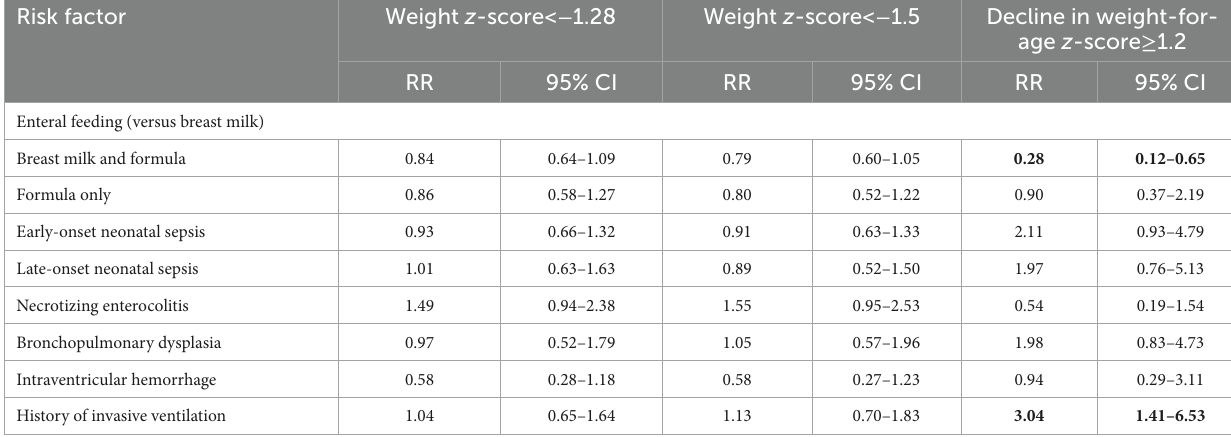
TABLE 4 Multivariate analysis on risk factors associated with postnatal growth failure.